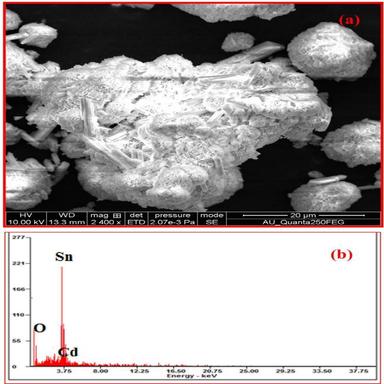
HR-SEM image of (a) CdO-SnO2 nanocomposite material and (b) EDX Analysis.